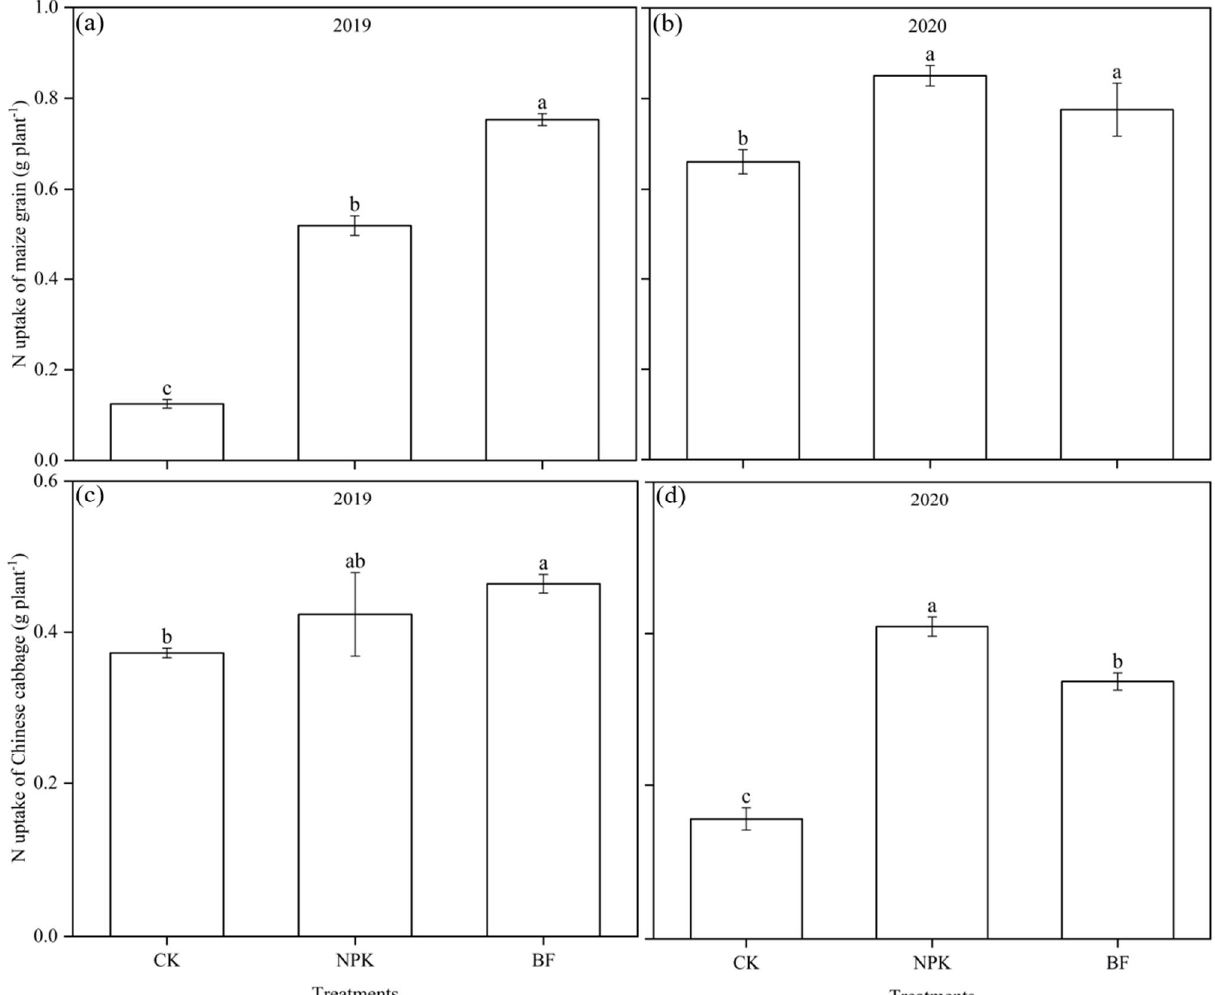
Figure 4. N uptake of maize and Chinese cabbage in 2019–2020 under different N treatments. ( a ), N uptake of maize in 2019. ( b ), N uptake of maize in 2020. ( c ), N uptake of Chinese cabbage in 2019. ( d ), N uptake of Chinese cabbage in 2020. The error bars show the standard deviations of the means (n = 3). Different lowercase letters indicate significant differences among treatments ( p < 0.05).